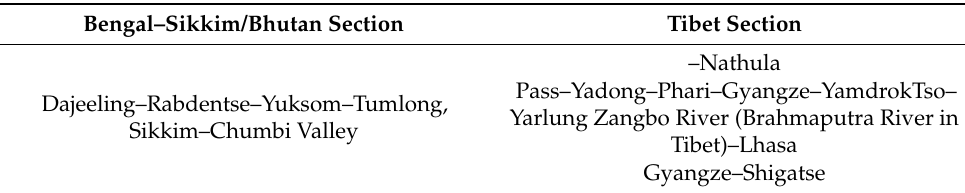
Table 4. Inferred routes from Bengal to Tibet via Sikkim and Bhutan (16th to the mid-18th century). Source: the authors; Reference